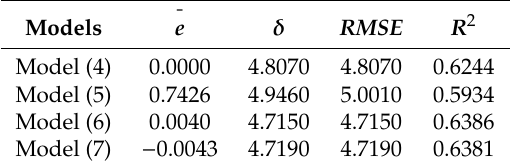
Table 2. Fit statistics of candidate base Equations (4)–(7) ( e , mean prediction error; δ , variance of biases; RMSE , root mean square error; and R 2 , coe ffi cient of determination).